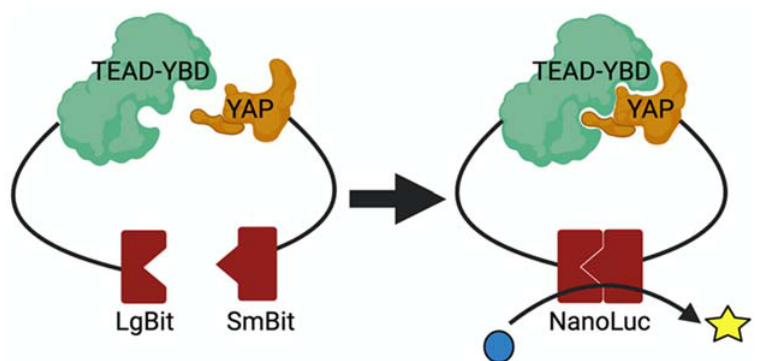
Figure 3. NanoLuc based bioluminescence assay. NanoLuc fragments, LgBit and Smbit are fused to TEAD and YAP respectively. Interaction between TEAD and YAP reconstitutes NanoLuc